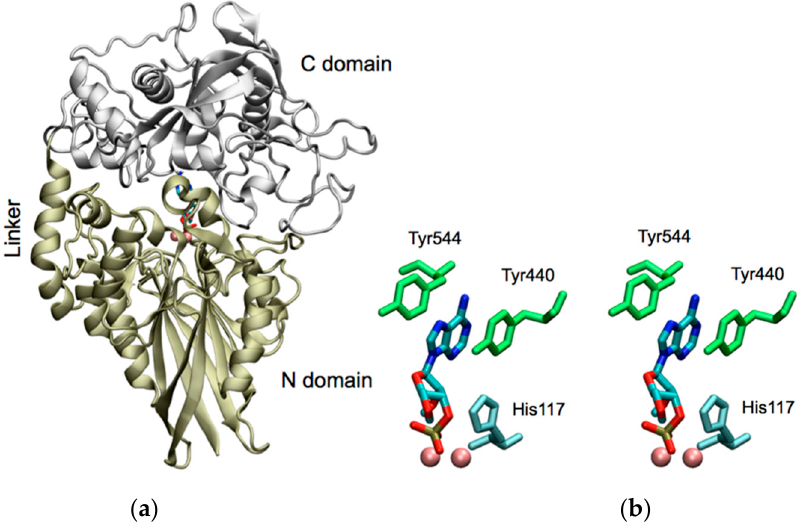
Figure 1. Structure of mature CpdB from E. coli with docked 3 ′ -AMP. ( a ) Homology model. The N-terminal domain (colored in tan, including the linker, residues 20–354) adopted the structure of a metallophos or calcineurin-like phosphoesterase domain, typical of the dimetallic metallophos- phoesterases or “metallodependent phosphatases” superfamily. Metal ions are colored in pink. The C-terminal domain (colored in silver; residues 355–647) adopted the 5_nucleotid_C structure that fits into the 5 ′ -nucleotidase family proteins. The model shows CpdB in a closed conformation with 3 ′ -AMP bound in the cleft between the metallophos and the 5_nucleotid_C domains. ( b ) Stereogram of 3´-AMP (colored by atom) docked to the active site in the closed conformation. Tyr 440 and Tyr 544 residues (green) belong to the C domain; His 117 (cyan) and the dinuclear metallic center belong to the N